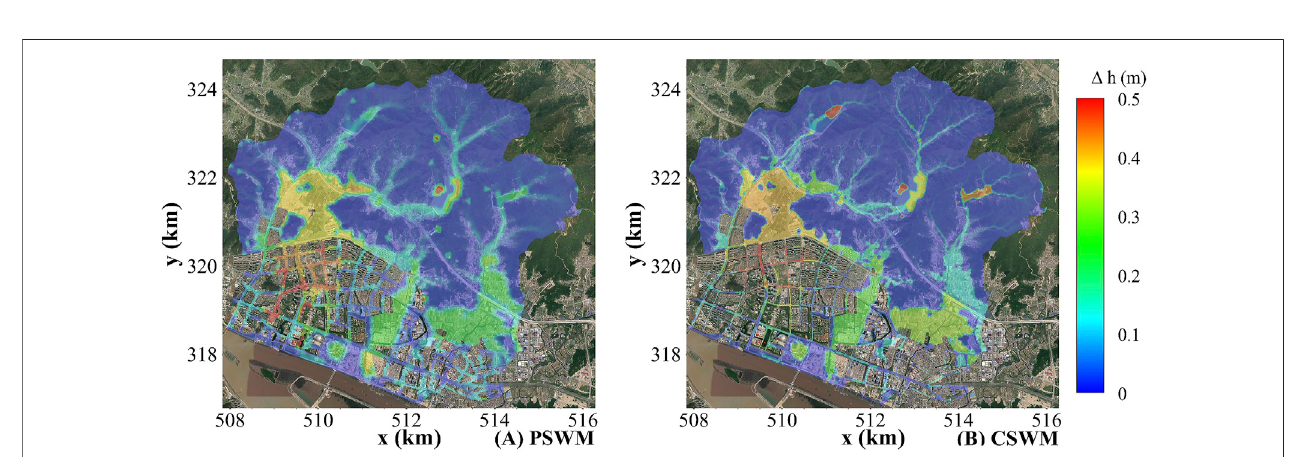
FIGURE 6 | Spatial distribution of depth increase from 12 to 15 h for. (A) PSWM and (B) CSWM.